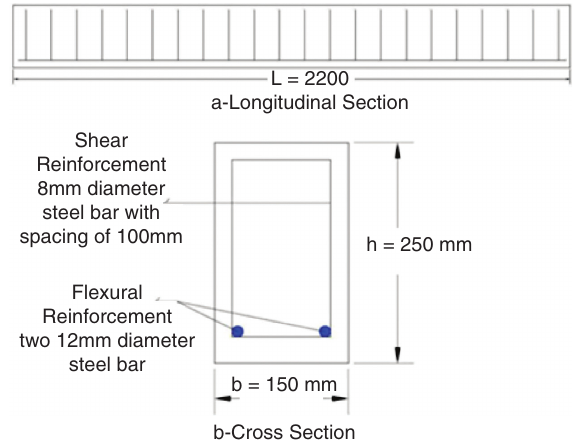
Fig. 1. RC beam dimensions and details